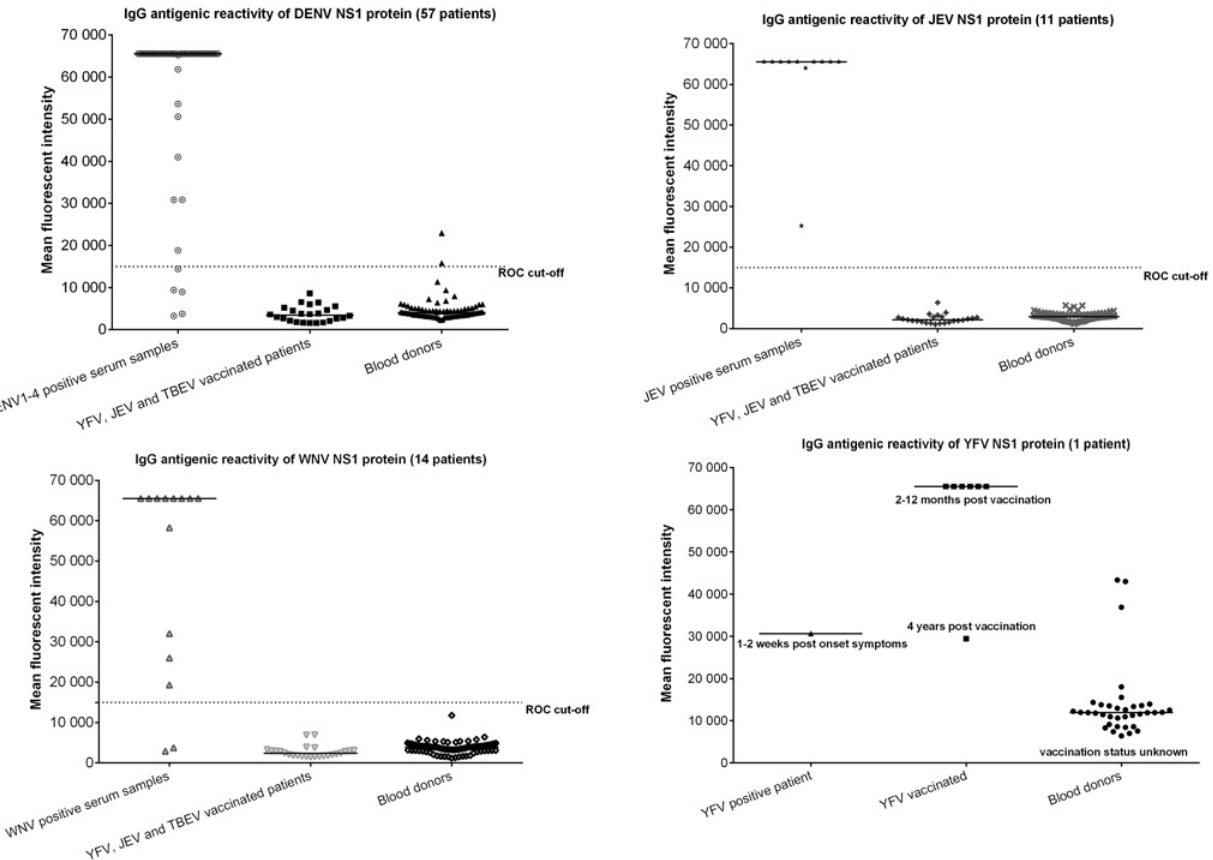
Fig 2. IgG fluorescent intensity (measured at 647nm) to flaviviruses in serum samples from clinical patients, persons vaccinated with YFV, JEV or TBEV and healthy blood donors in a 1:20 serum dilution. NS1 proteins were spotted in a 0,5mg/ml concentration. Y axis represents the fluorescent intensity. The median signal is depicted as a line. The dotted line represents the calculated cut-off by the ROC used to determine antibody